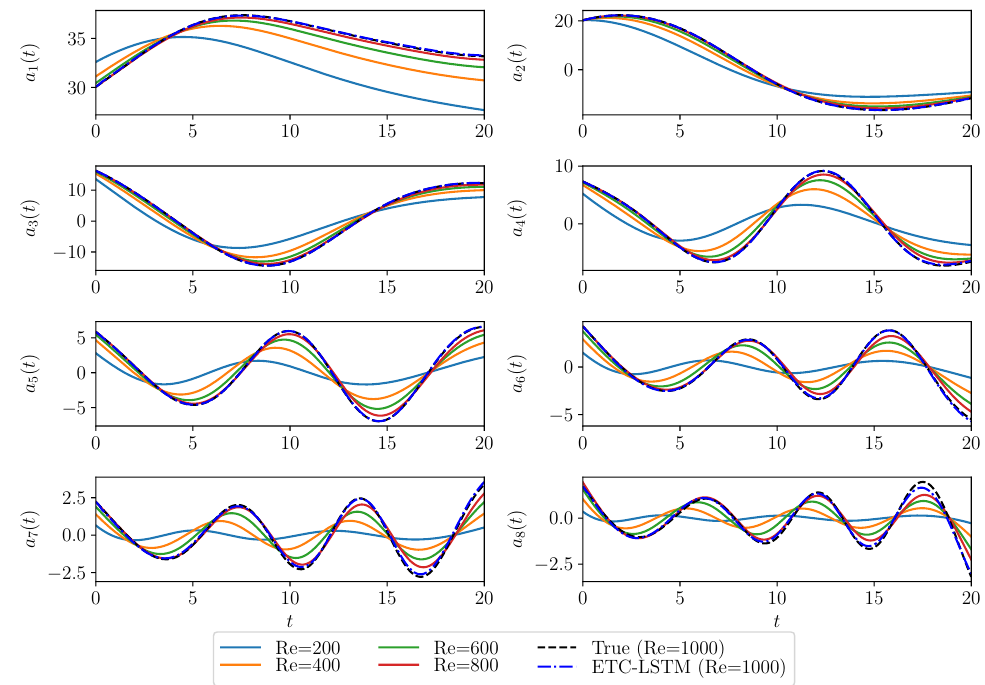
Figure 8. Evolution of vorticity modal coefficients for different training Reynolds numbers and the test Reynolds number (Re = 1000) with γ = 0.01. The time series for Re = [ 200,400, 600,800 ] are true vorticity modal